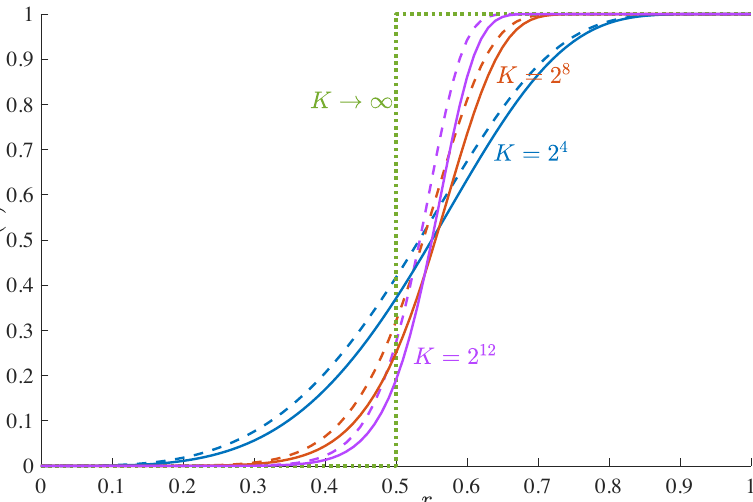
Figure 2. CDF of the squared total error (solid lines) and squared angle error (dashed lines) for rate R = 1 and various numbers of columns K 2